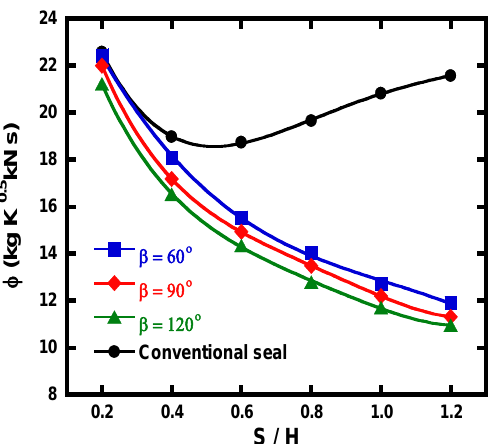
Figure 15. Variation in the flow function with S/H and β (PR = 2.5, t/K = 0.2).